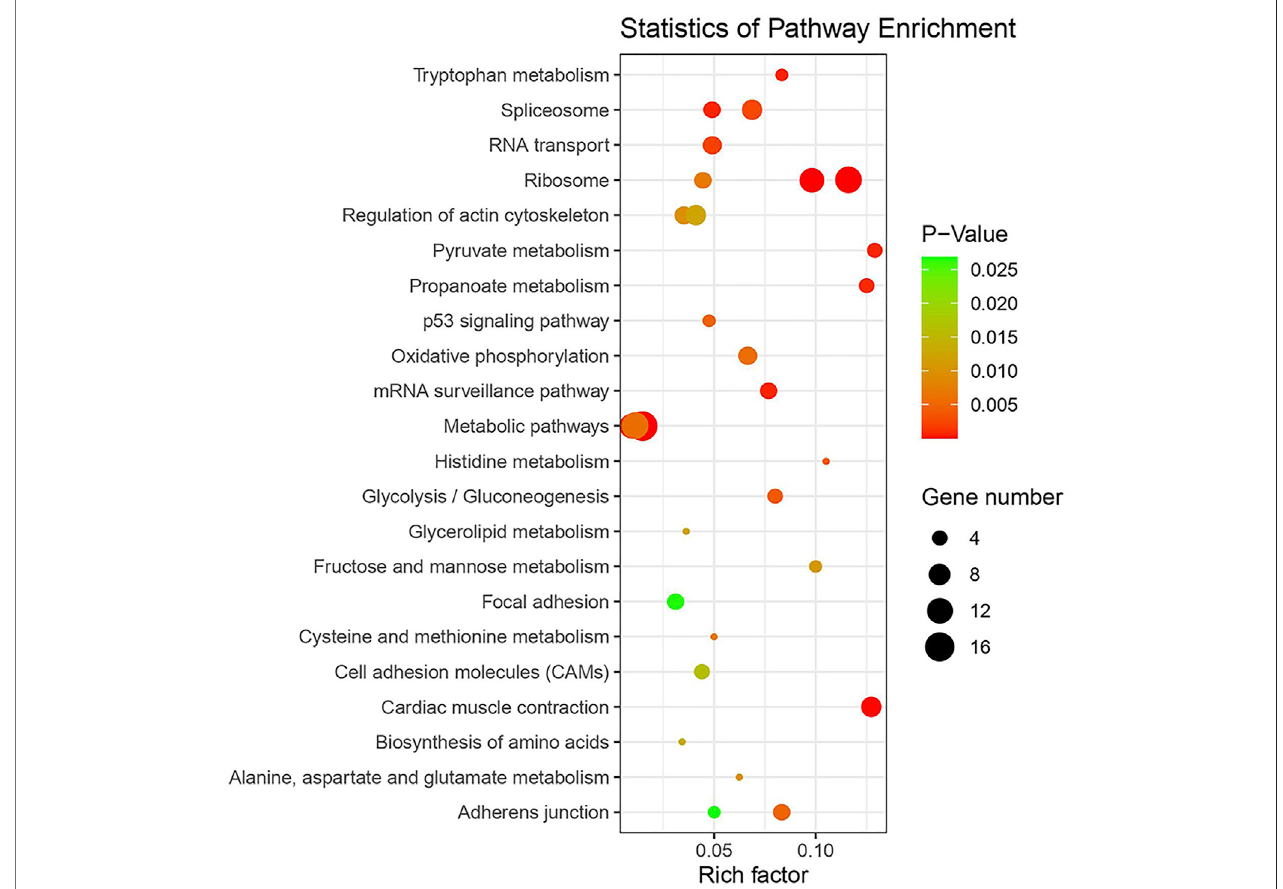
FIGURE 8 | KEGG pathway enrichment analysis of AS genes in 10 most enriched pathways from each tissue.